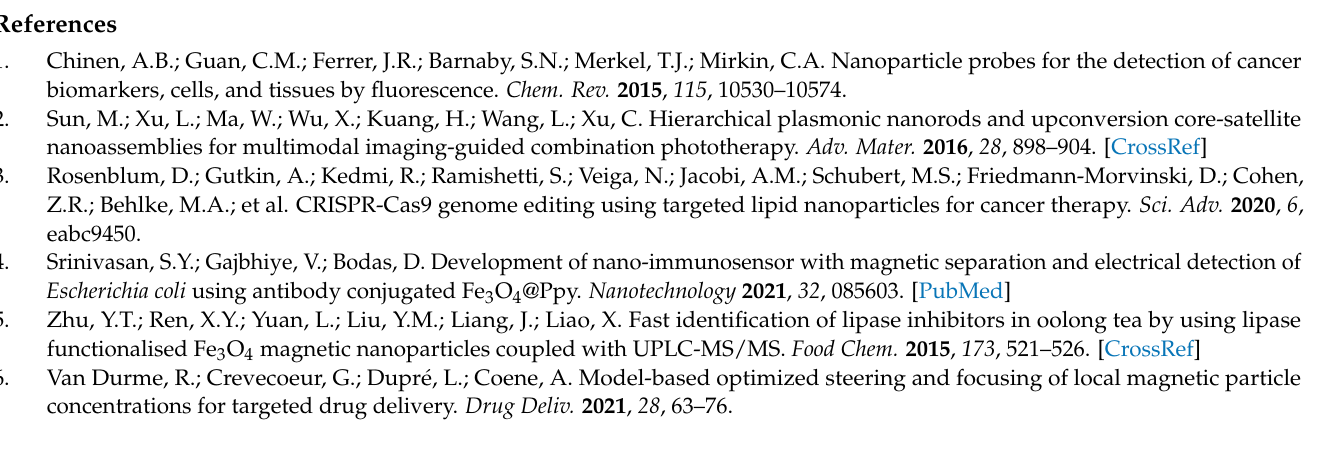
C-NMR spectra of compound 1, Figure S7: MS Spectra of compound 1, Figure S8: 1 H-NMR spectra of compound 2, Figure S9: 13 C-NMR spectra of compound 2, Figure S10: MS Spectra of compound 2, Figure S11: 1 H-NMR spectra of compound 3, Figure S12: 13 C-NMR spectra of compound 3, Figure S13: MS Spectra of compound 3, Figure S14: 1 H-NMR spectra of compound 4, Figure S15: 13 C-NMR spectra of compound 4, Figure S16: 1 H-NMR spectra of compound 5, Figure S17: 13 C-NMR spectra of compound 5, Figure S18: 1 H-NMR spectra of compound 6, Figure S19: 13 C-NMR spectra of compound